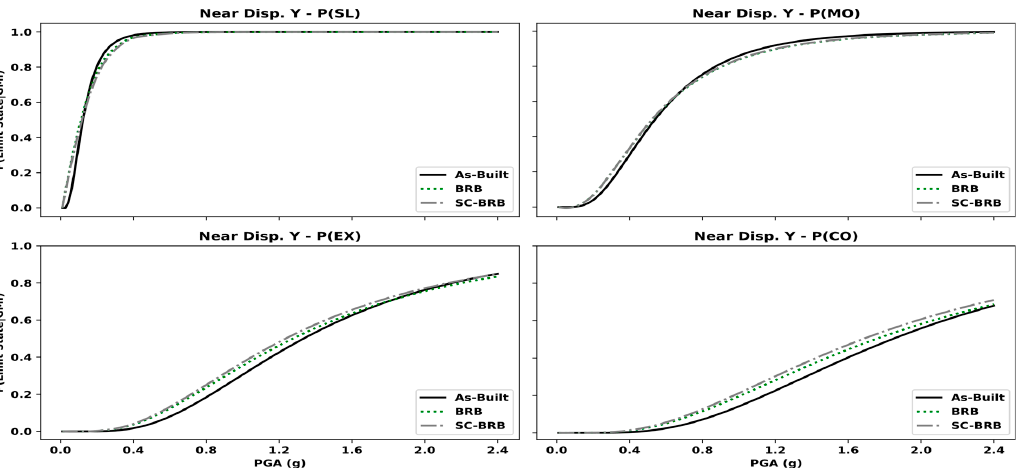
Figure 27. Fragility curves of BD demands under far-field records in the transverse direction (as- built vs. retrofitted bridges with different BRB techniques).